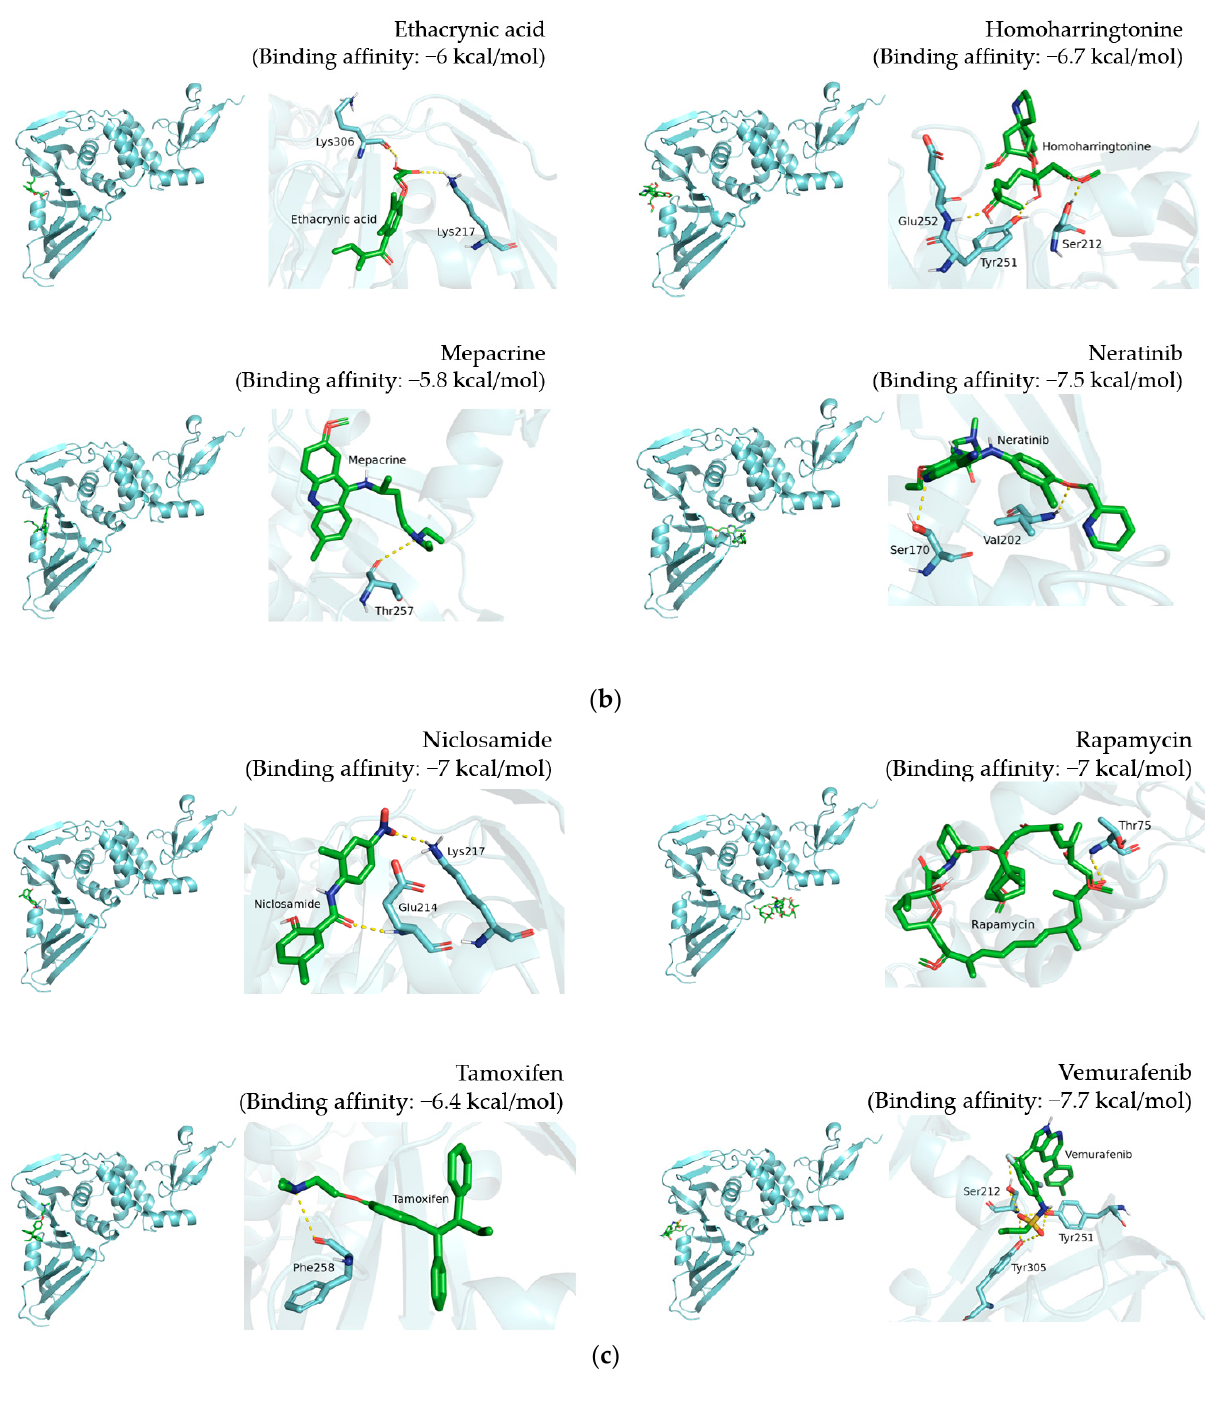
Figure 3. Docking results of 12 candidate compounds for PL pro . ( a ) Afatinib, atorvastatin, dactinomycin and doxorubicin. ( b ) Ethacrynic acid, homoharringtonine, mepacrine and neratinib. ( c ) Niclosamide, rapamycin, tamoxifen and vemurafenib. These results present the pose 1 binding pattern of each compound in the whole protein and polar contact residue view. PL pro and compounds are shown in cyan and green, respectively. The polar contacts are marked with yellow dashes.